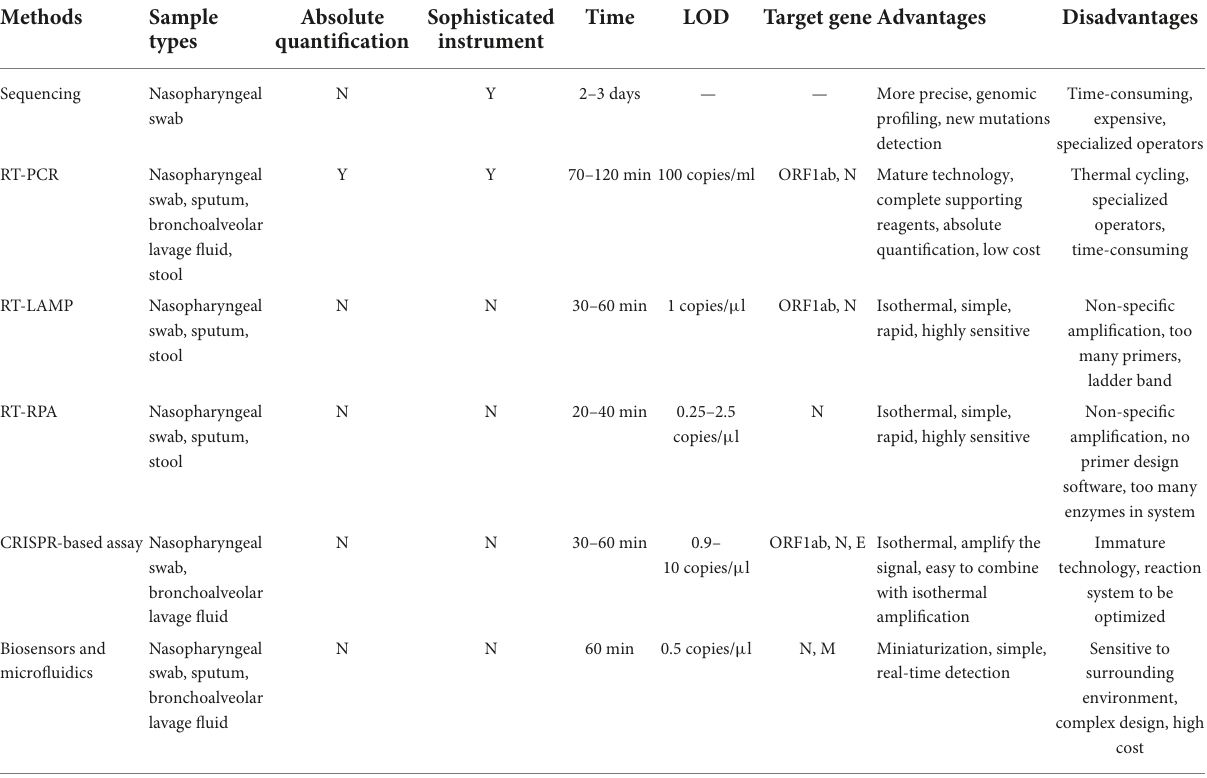
TABLE 2 Comparison of different SARS-CoV-2 nucleic acid detection